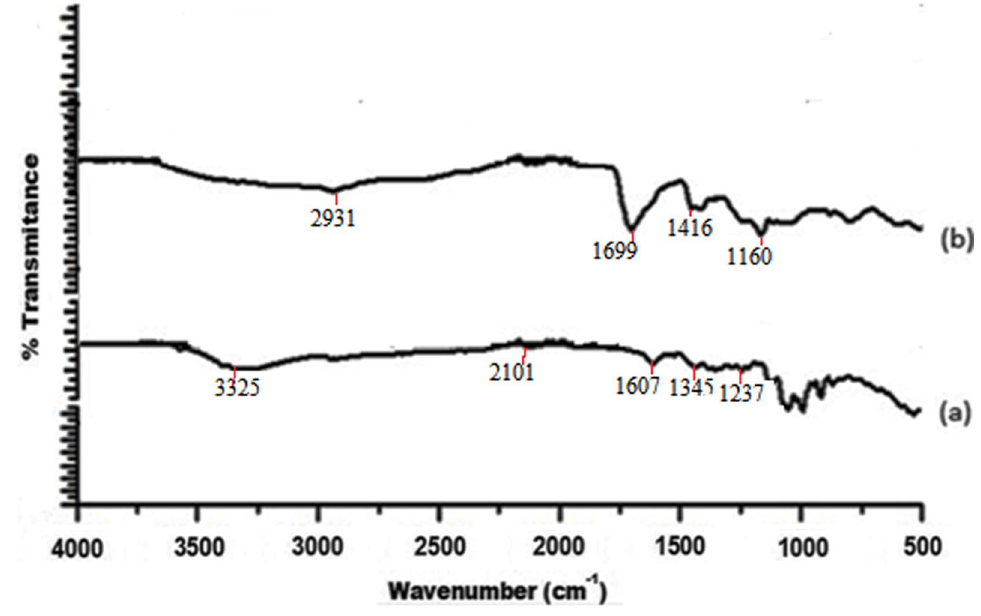
Fig. 1 a, b FT-IR spectra of a aloe vera and b Av-cl-poly(AA)